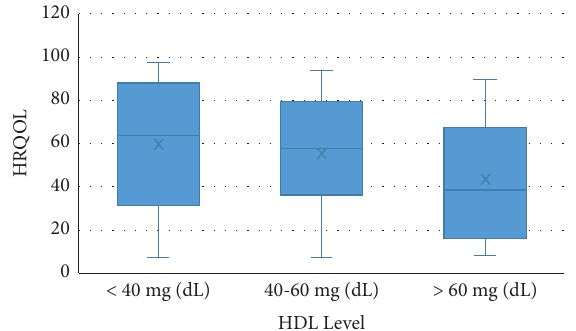
Figure 2: Association between HDL level and